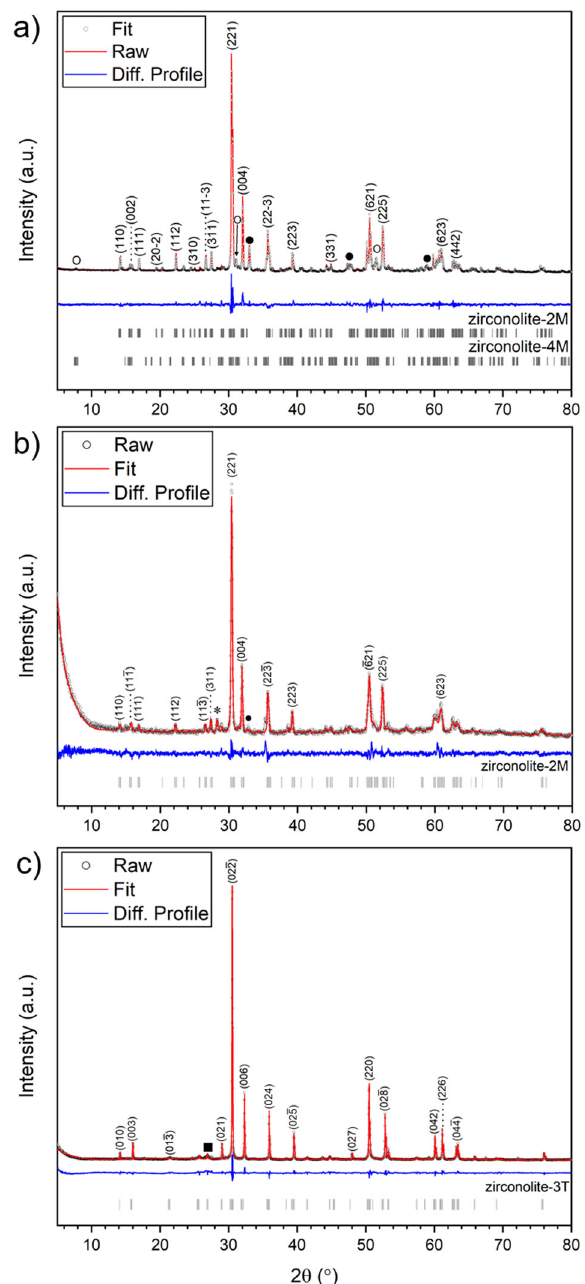
Fig. 1 Re fi ned powder diffraction pro fi les of zirconolite ceramic materials. Showing a HIPed CaZr 0.80 Ce 0.20 Ti 2.00 O 7; b HIPed CaZ- values. Diagnostic zirconolite-4M re fl ections are labelled with open circles (o). Perovskite re fl ections are labelled with closed circles. UO 2 re fl ections are labelled with asterisks. Al 2 TiO 5 re fl ections are labelled with closed